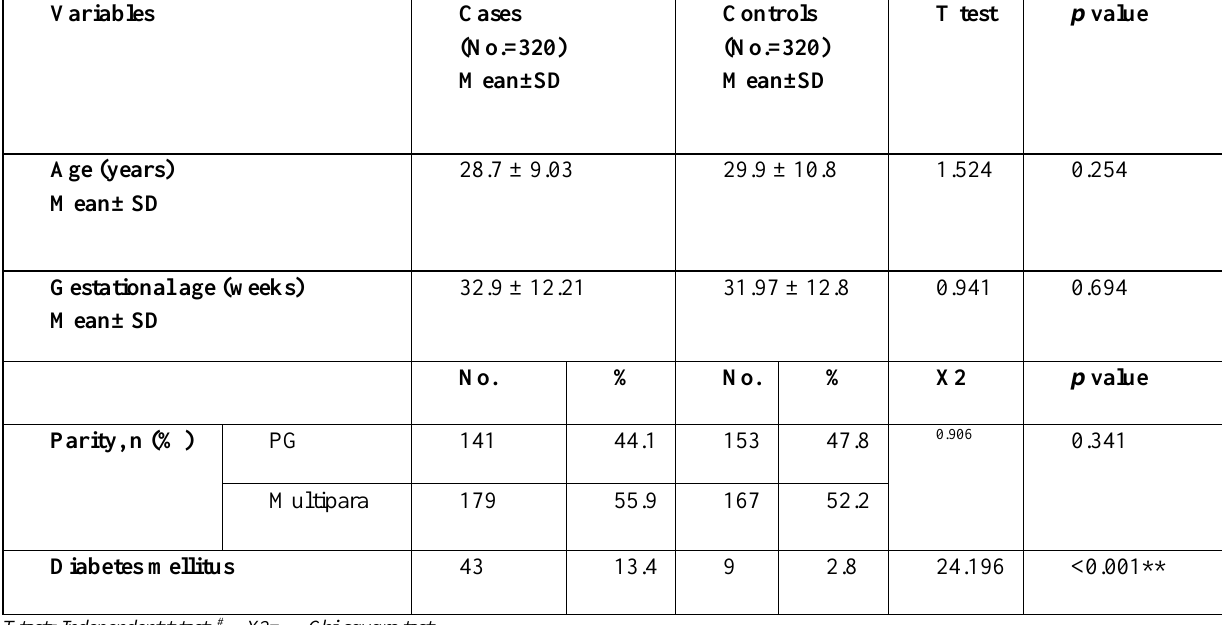
Table 1. Basic characteristics of studied groups.